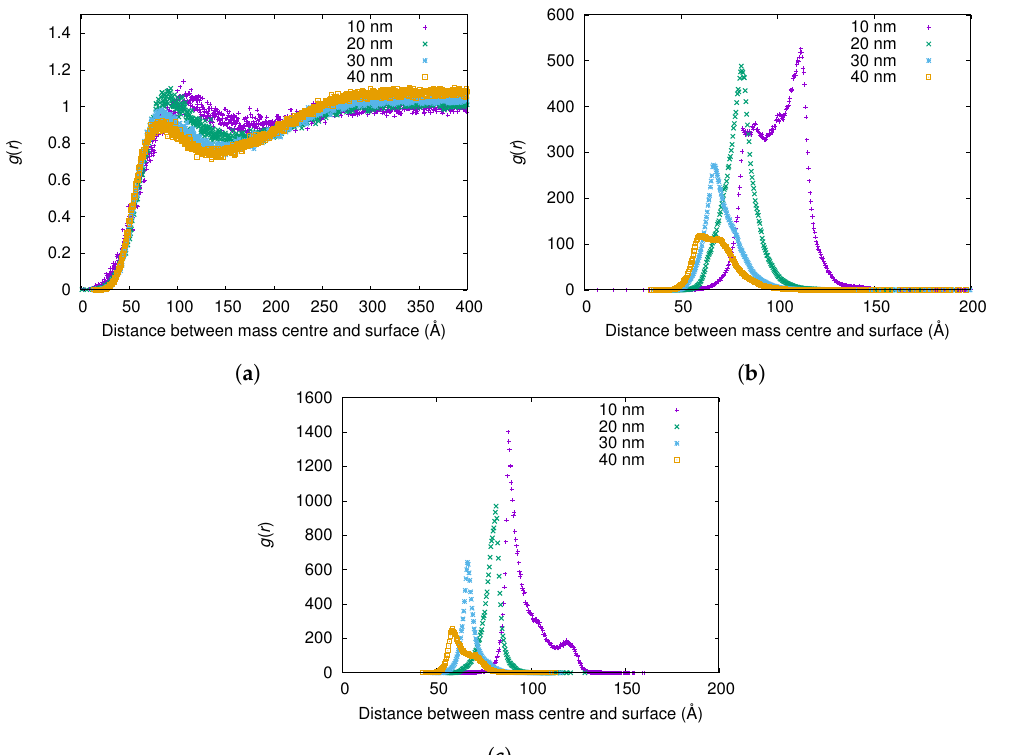
Figure 5. The radial distribution function g ( r ) between the surface of the nanoparticle and the mass center of the main body of fibrinogen for different nanoparticle radii and surface charge densities: ( a ) − 0.001 e /Å 2 ; ( b ) − 0.005 e /Å 2 ; and ( c ) − 0.01 e /Å 2 . The g ( r ) are normalized using the (constant) concentration of fibrinogen in the simulation box instead of a bulk concentration for each simulation, since reliable bulk concentrations could not be determined from the simulations with highest attraction to the surface. Table 2. The adsorbed proportion of the fibrinogen main body per surface area in simulations with a single nanoparticle with different radii when the surface charge density is − 0.001 e /Å 2 . Nanoparticle Radius